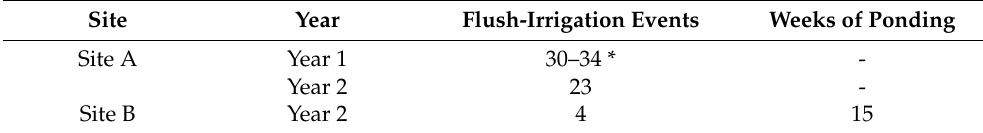
Table 2. Total number and type of irrigation events conducted across both